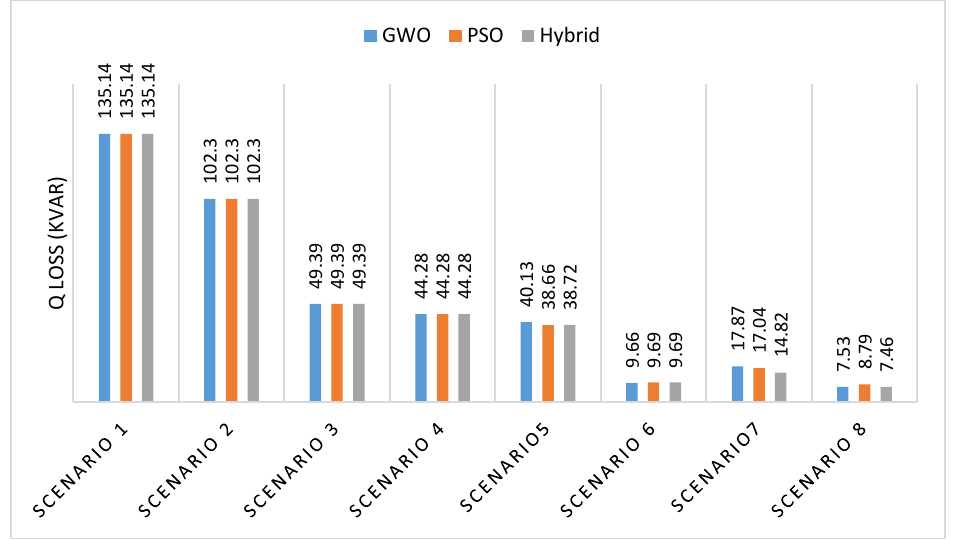
Figure 5. Reactive loss of a 33-bus system using three different techniques.